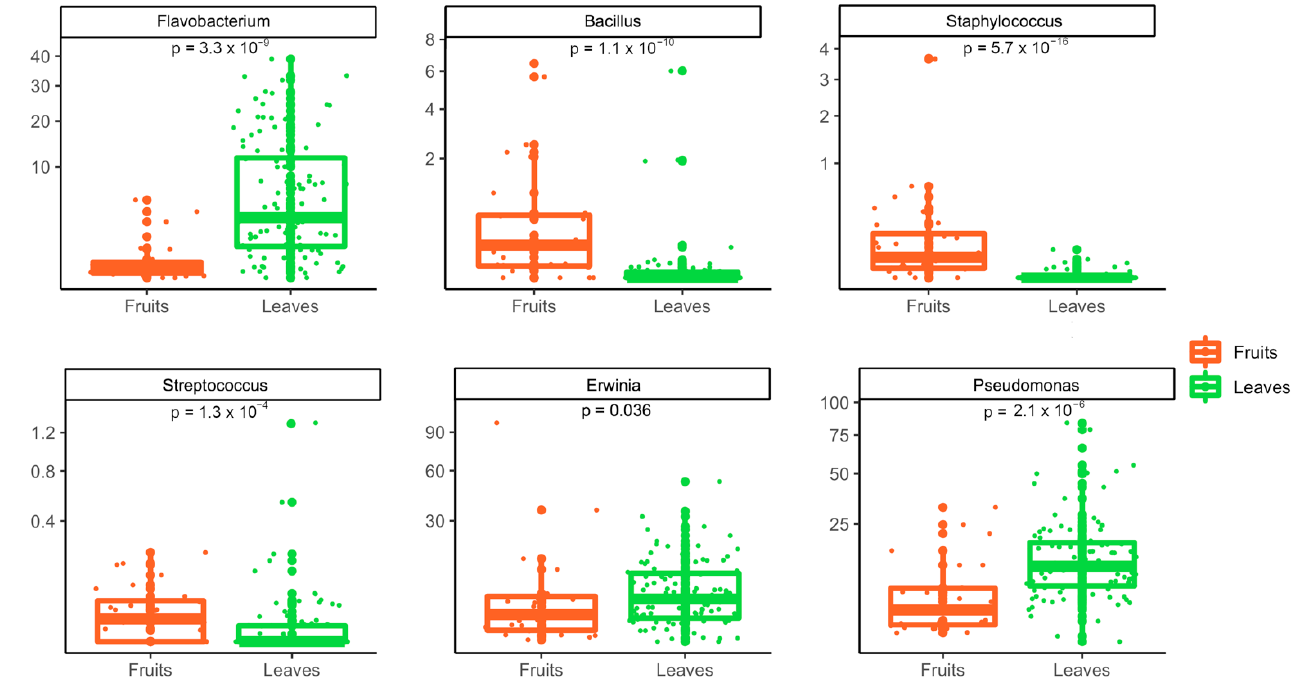
Figure 5. Bacterial genera showing a significant difference between fruits and leaves.